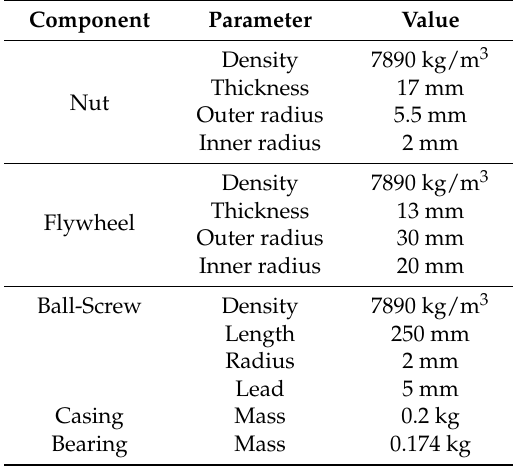
Table 1. Key components of the ball-screw inerter and their parametric